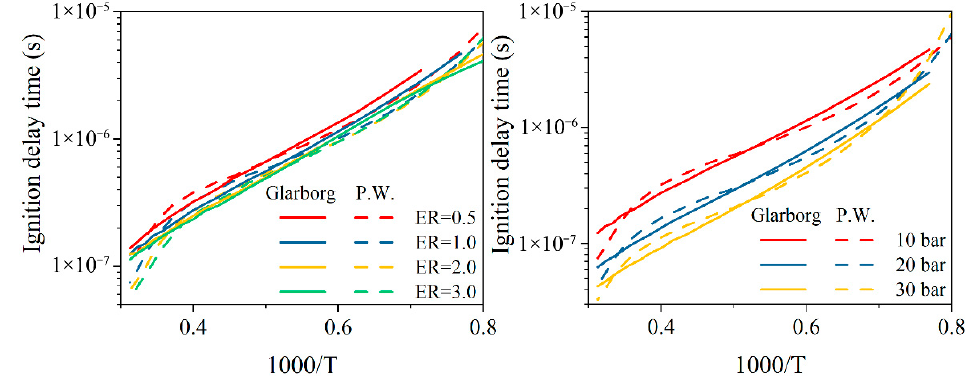
Figure 3. Influence of different pressure ( left ) and different equivalent ratio ( right ) on ignition delay time. P.W.—present work. Glarborg—[35]. time. P.W.—present work.